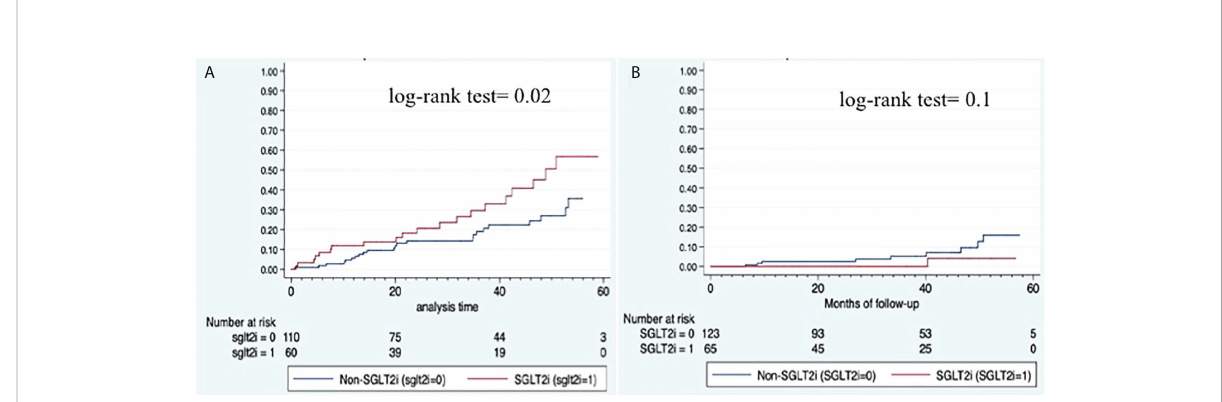
FIGURE 2 Kaplan-Meier survival curves. (A) Overall infections; (B) Hepatic